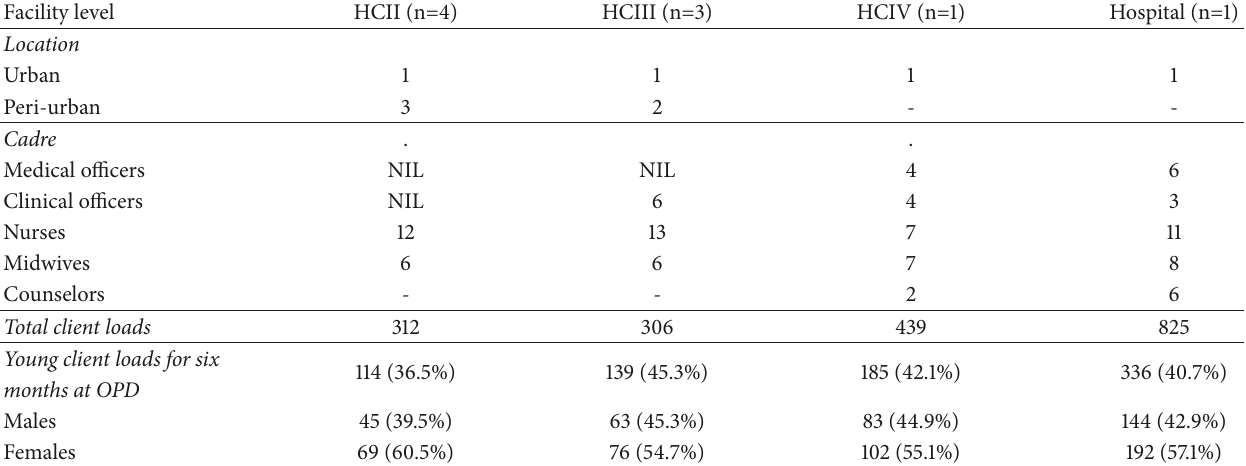
Table 2: Characteristics of study health facilities in Mbarara